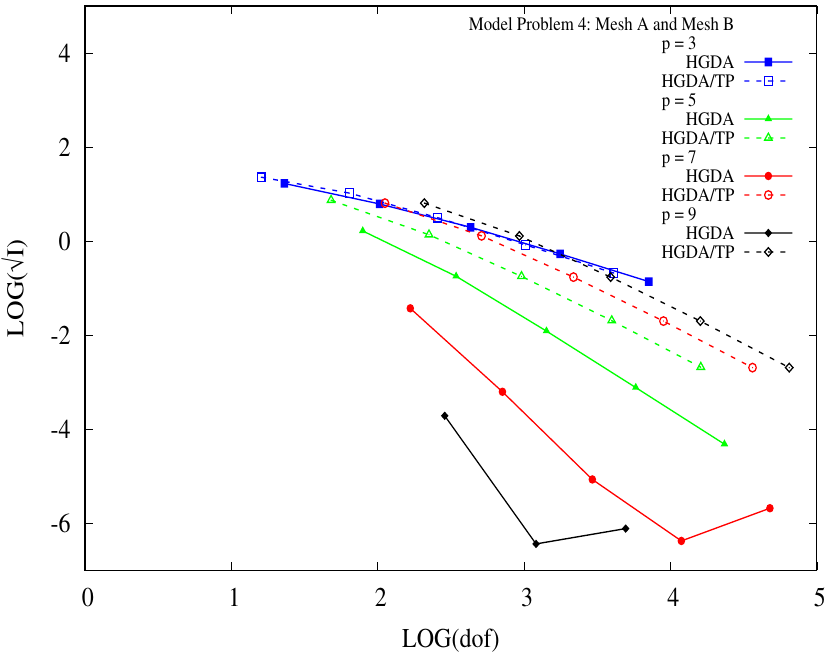
Figure 19. Residual function I versus dof, C 11 solutions: Model Problem 4 (Poisson’s Equation; Mesh B, HGDA/DG; Mesh A,